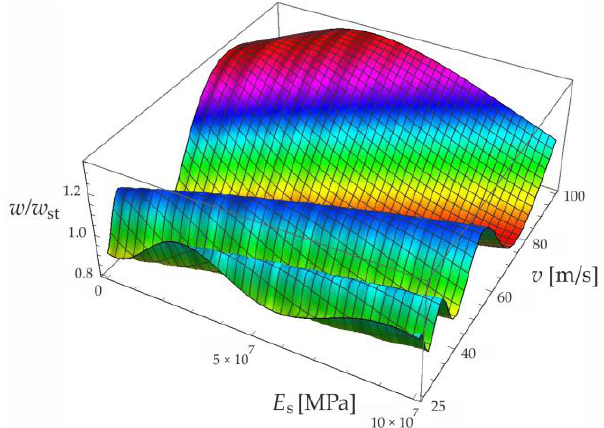
Figure 7. Effect of moving force velocity and a foundation ’s Young ’ s modulus on the deflection of the midpoint of a simply supported beam under forced vibration.